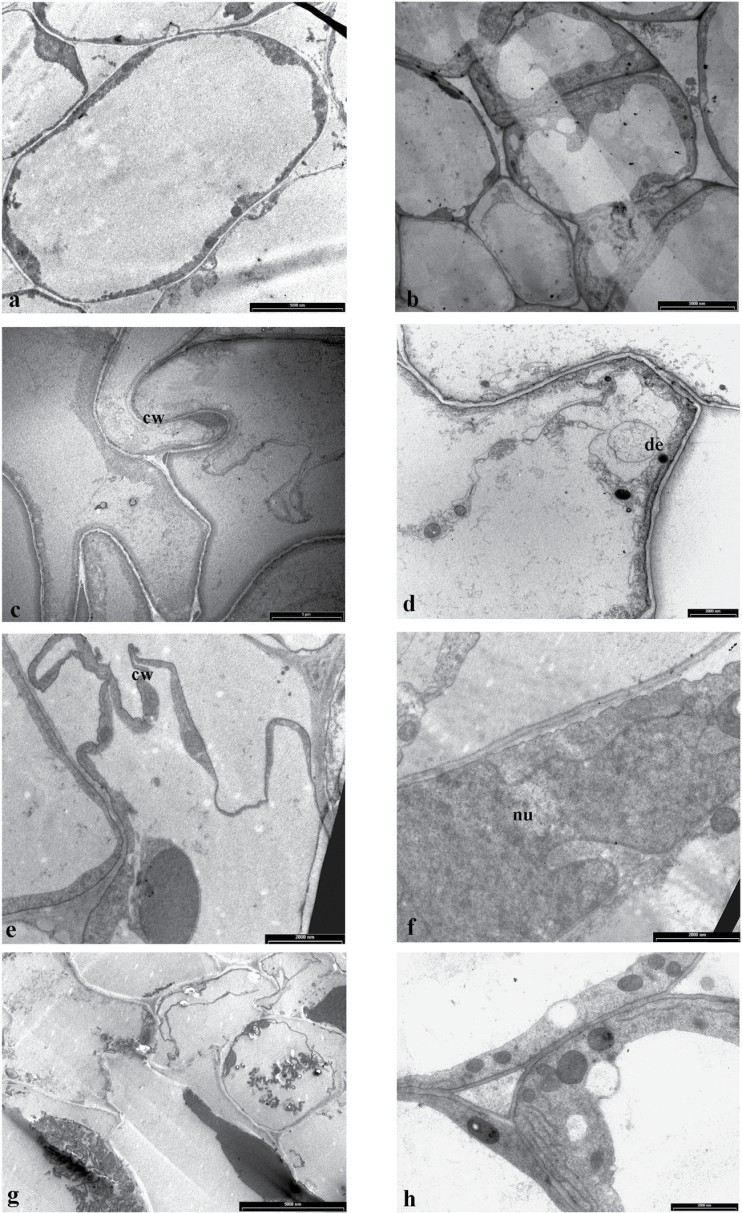
Electron micrographs of transverse section of root cells of tobacco plants exposed to increasing concentration of ZnSO4. (a, b) Plants grown in the control nutrient solution for 3 weeks showing a cortical cell (a) and central cylinder cells (b). (c, d) Cortical cells of plants grown with 250 μM ZnSO4 with no prior acclimation period showing a tortuous cell wall (c) and a damaged cell with deposits (d). (e, f) Plants grown for 1 week with 30 μM ZnSO4 and then exposed to 250 μM ZnSO4 showing irregular cell walls (e) and an irregular nucleus (f). (g) Plants grown with 500 μM ZnSO4, with no prior acclimation period, with disintegrated cytoplasmic organules in the cells of the central cylinder. (h) A cortical cell of plants grown for 1 week with 30 μM ZnSO4 and then exposed to 500 μM ZnSO4 with well-preserved cytoplasmic organules. cw, cell wall; de, deposit; nu, nucleus.